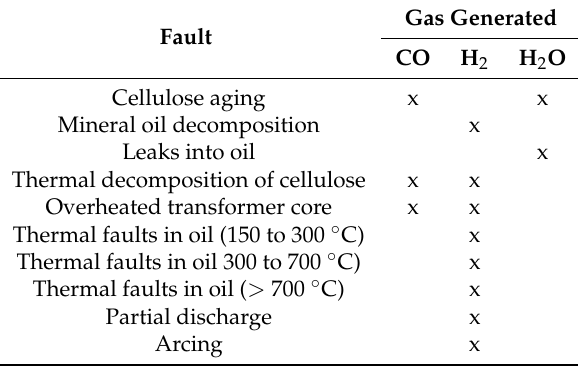
Table 2. Initial fault identification chart [46].